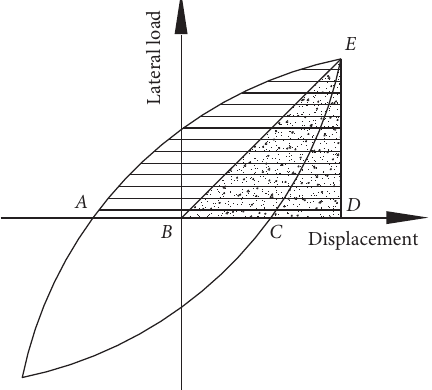
Figure 13: Schematic diagram of energy Table 9: Equivalent viscous damping coefficients of specimens. No.